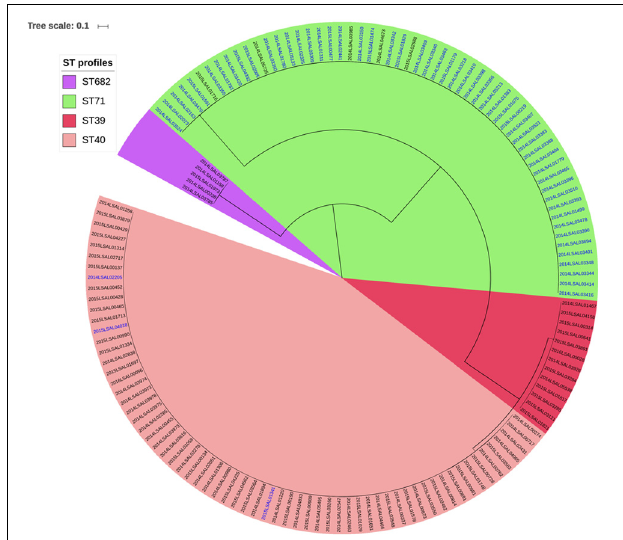
FIGURE 1 | Phylogenetic SNP tree for 140 strains of S. Derby constructed under the maximum likelihood criterion using the GTR-gamma model. The scale bar indicates the number of substitutions per site. Four clusters were identified and named ST39, ST40, ST71, and ST682 with reference to the MLST profiles with which the correspondence is perfect. The labels in blue correspond to the strains of the poultry sector. The black labels correspond to the strains of the pork